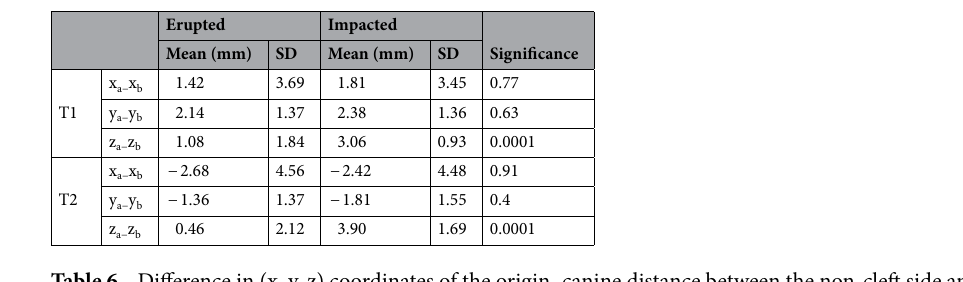
Table 6. Difference in (x, y, z) coordinates of the origin–canine distance between the non-cleft side and cleft side in T1 and T2.